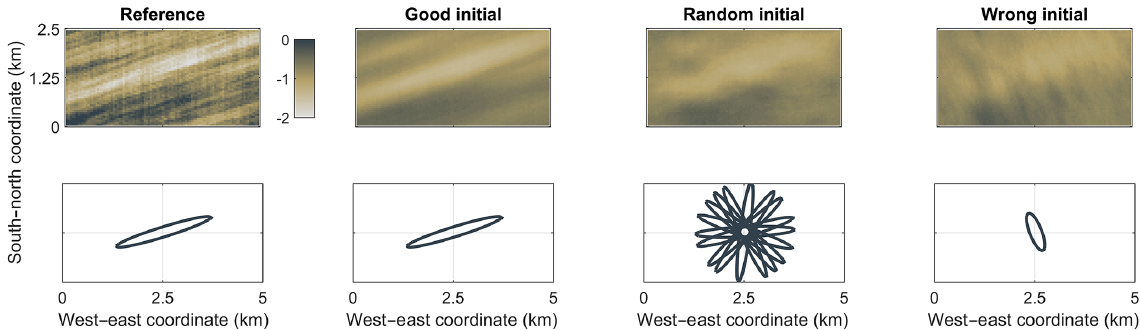
Figure 3. Estimation of stand-alone recharge. Upper panels show the final ensemble mean after all assimilation steps, and lower plots the covariance function used to generate the initial ensemble. Please note that the random covariance functions imply drawing the rotation angle from a uniform distribution between 0 and 2 π , whereas only a few illustrative examples are